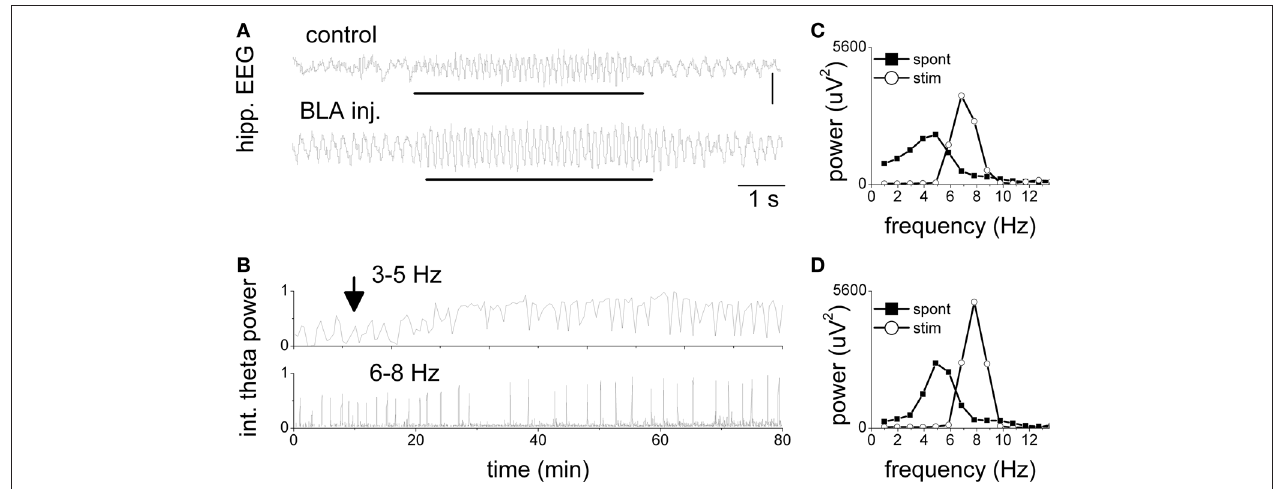
FiguRE 2 | increase in spontaneous and elicited theta activity in the hippocampus after picrotoxin injection in the BLA. (A) Traces of hippocampal EEG during stimulation of the pontine reticular formation (see markers) 10 min before and 50 min after injection. Note high frequency (7 Hz) theta oscillations during stimulation replacing non-theta EEG in control and slow (4 Hz) spontaneous theta after injection. (B) Theta power in the slow (3–5 Hz) and fast